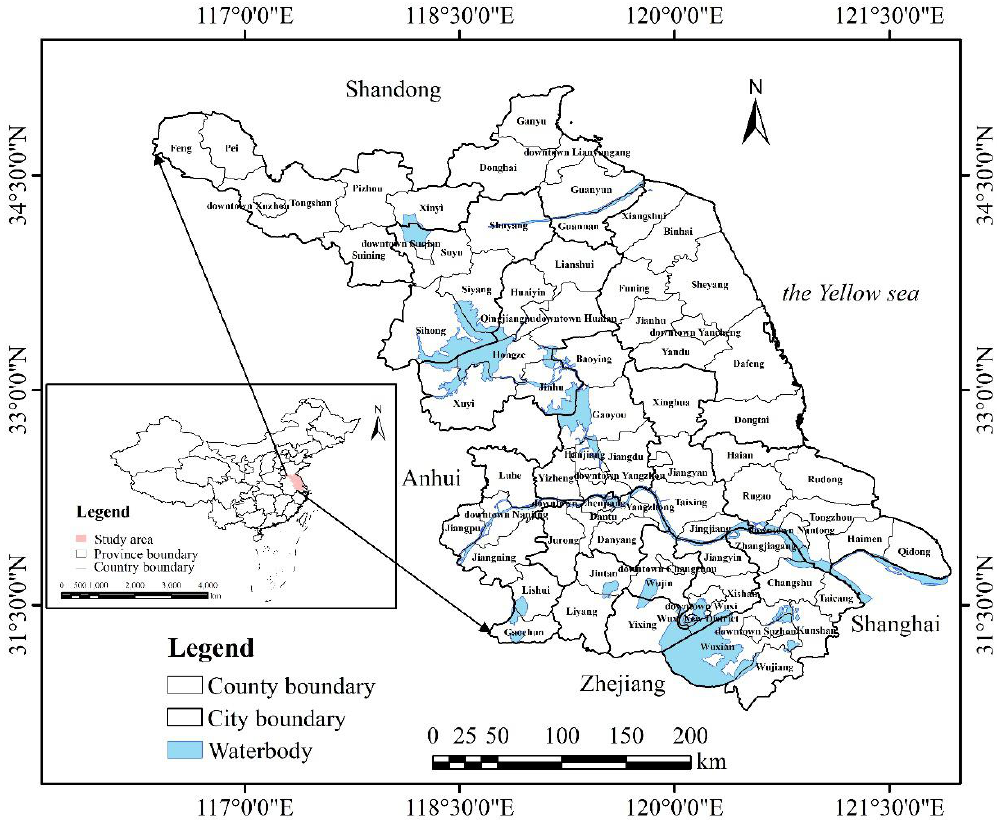
Figure 1. Location of study area in eastern China and 78 counties in the region.